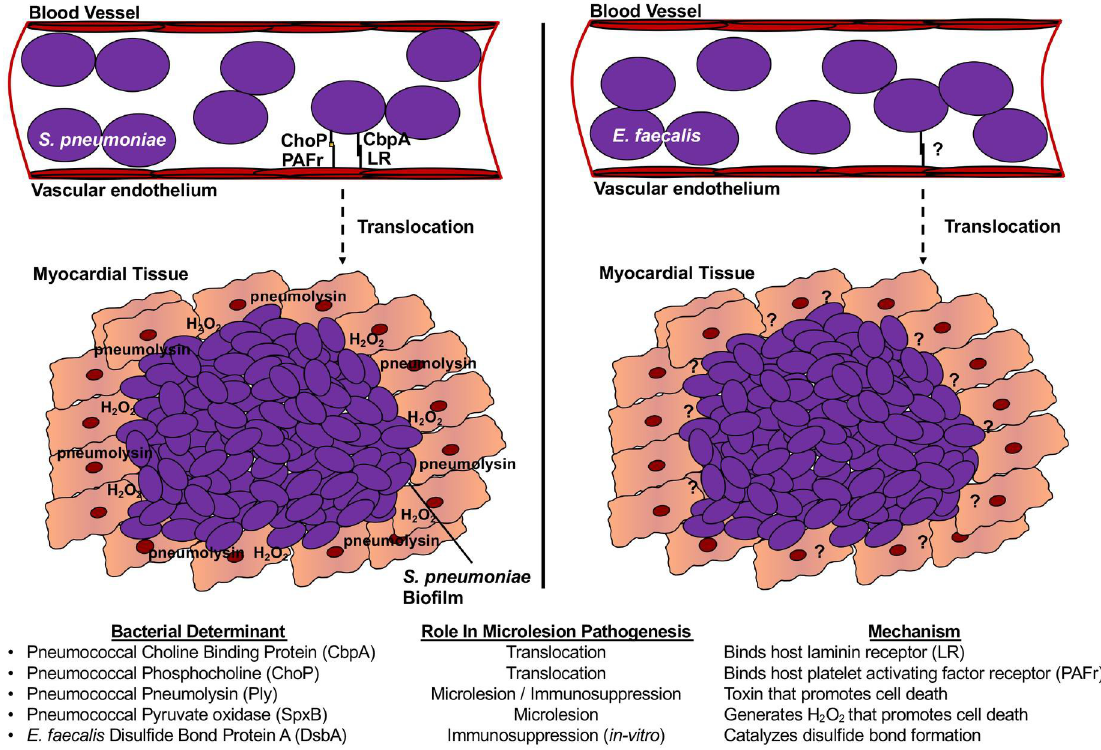
Fig 1. Virulence determinants known to contribute to microlesion formation. A model summarizing the known bacterial virulence determinants known to contribute to the formation of cardiac microlesion by facilitating vascular translocation, cell death, or immune suppression. CbpA, choline-binding protein A; ChoP, phosphocholine; DsbA, disulfide bond protein A; LR, laminin receptor; PAFr, platelet activating factor; Ply, pneumolysin; SpxB, pyruvate